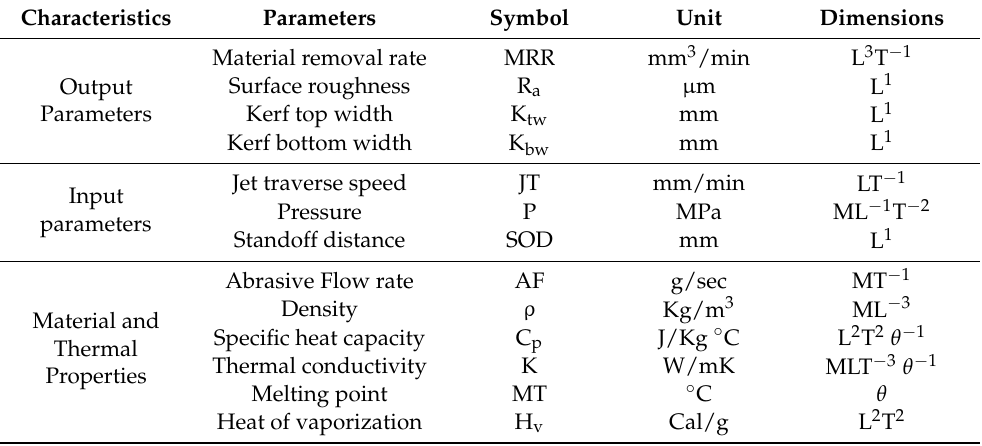
Table 1. The dimensions of the AWJM process